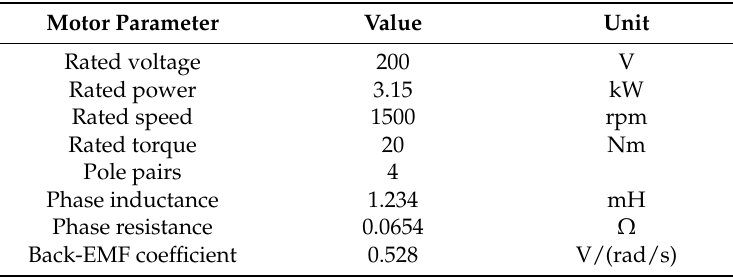
Figure 11. Experimental setup of the BLDC motor drive system. Table 4. Motor parameters.